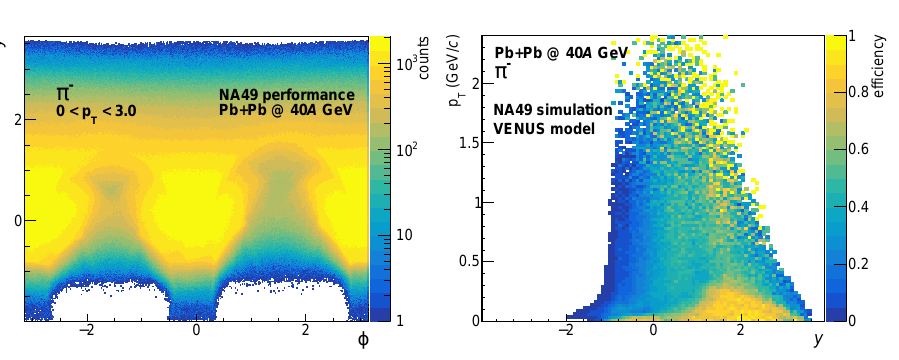
Figure 3. Left: Distribution of azimuthal angles and rapidity for negatively charged pions. Right: E ffi ciency as a function of transverse momentum and rapidity for negatively charged